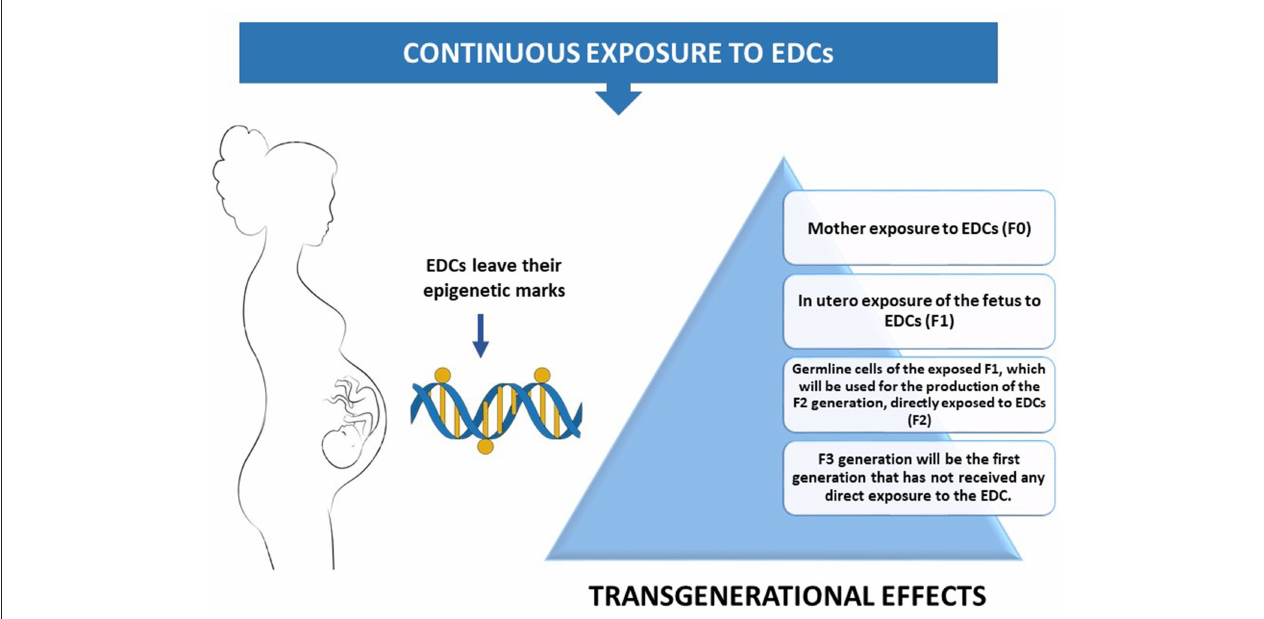
FIGURE 2 | A pregnant mother’s exposure to the environment can inadvertently introduce EDCs into the exquisitely calibrated hormonal milieu of the embryo.